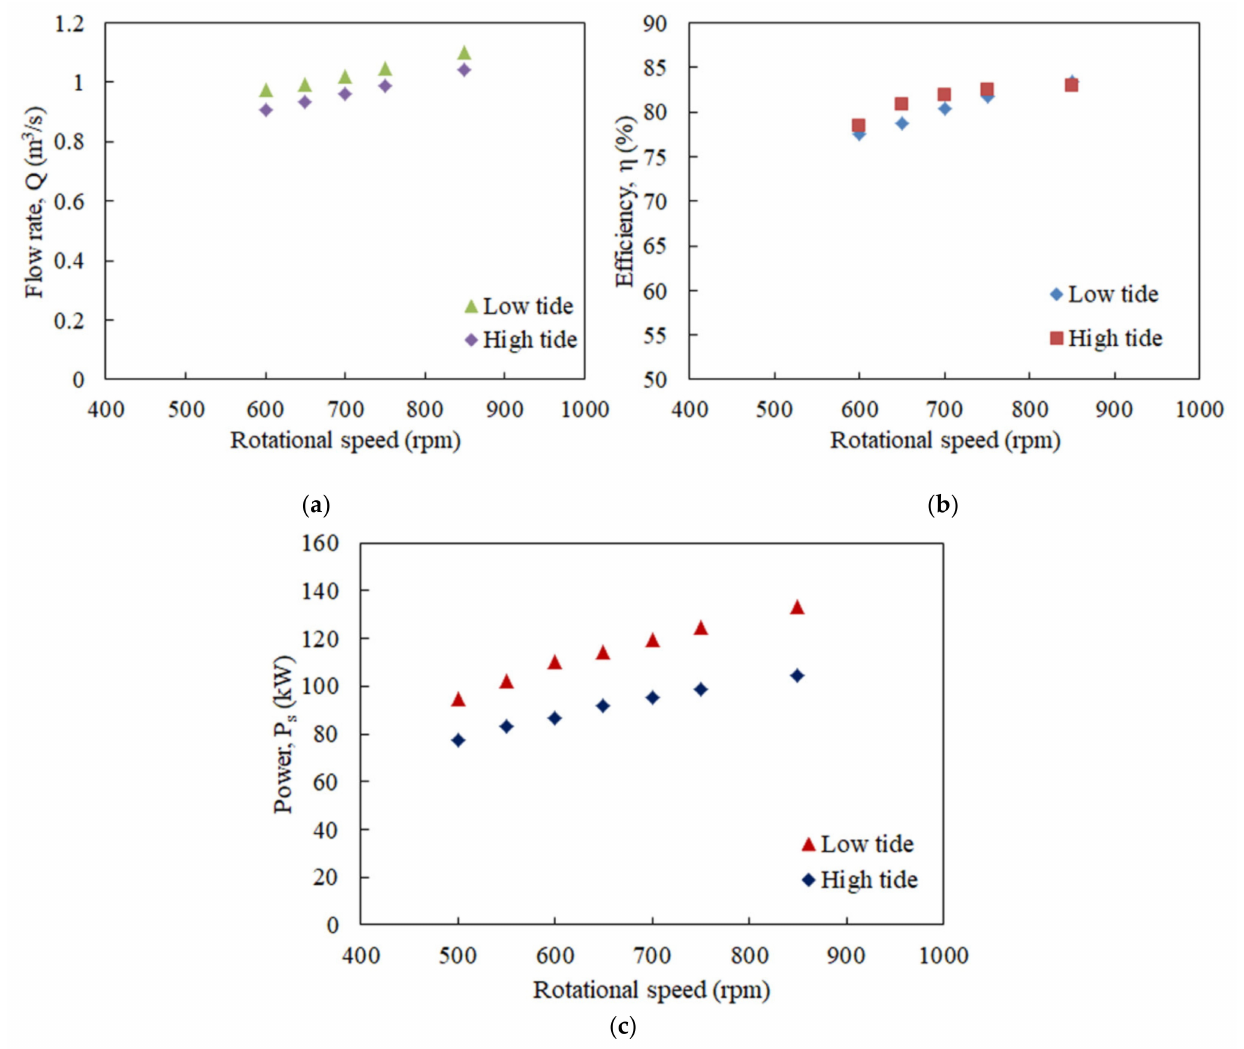
Figure 28. Performance changes according to rotational speed and tidal level: ( a ) rotational speed versus flow rate; ( b ) rotational speed versus efficiency; ( c ) rotational speed versus